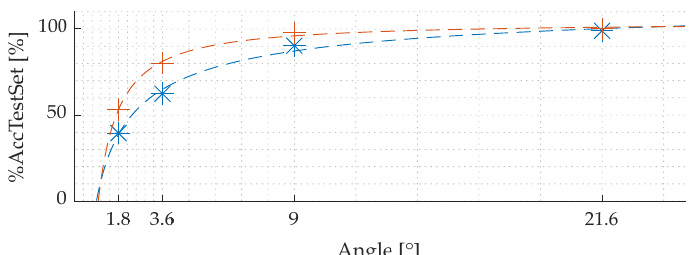
Figure 10. Values of the accuracy %AccTestSet distribution over successive angular step sizes prior (blue colour plot) and after (orange plot) application of the predictions updating algorithm.